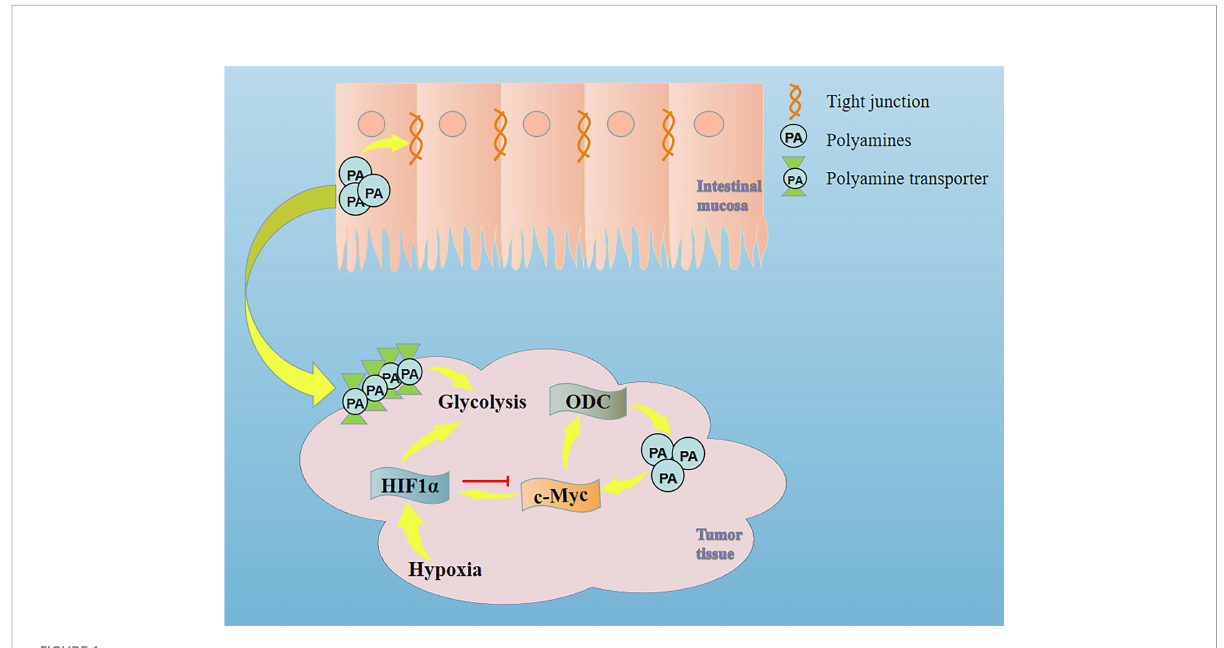
FIGURE 1 Mechanism of intestinal mucosal barrier damage caused by tumor tissue plundering polyamines in intestinal mucosal